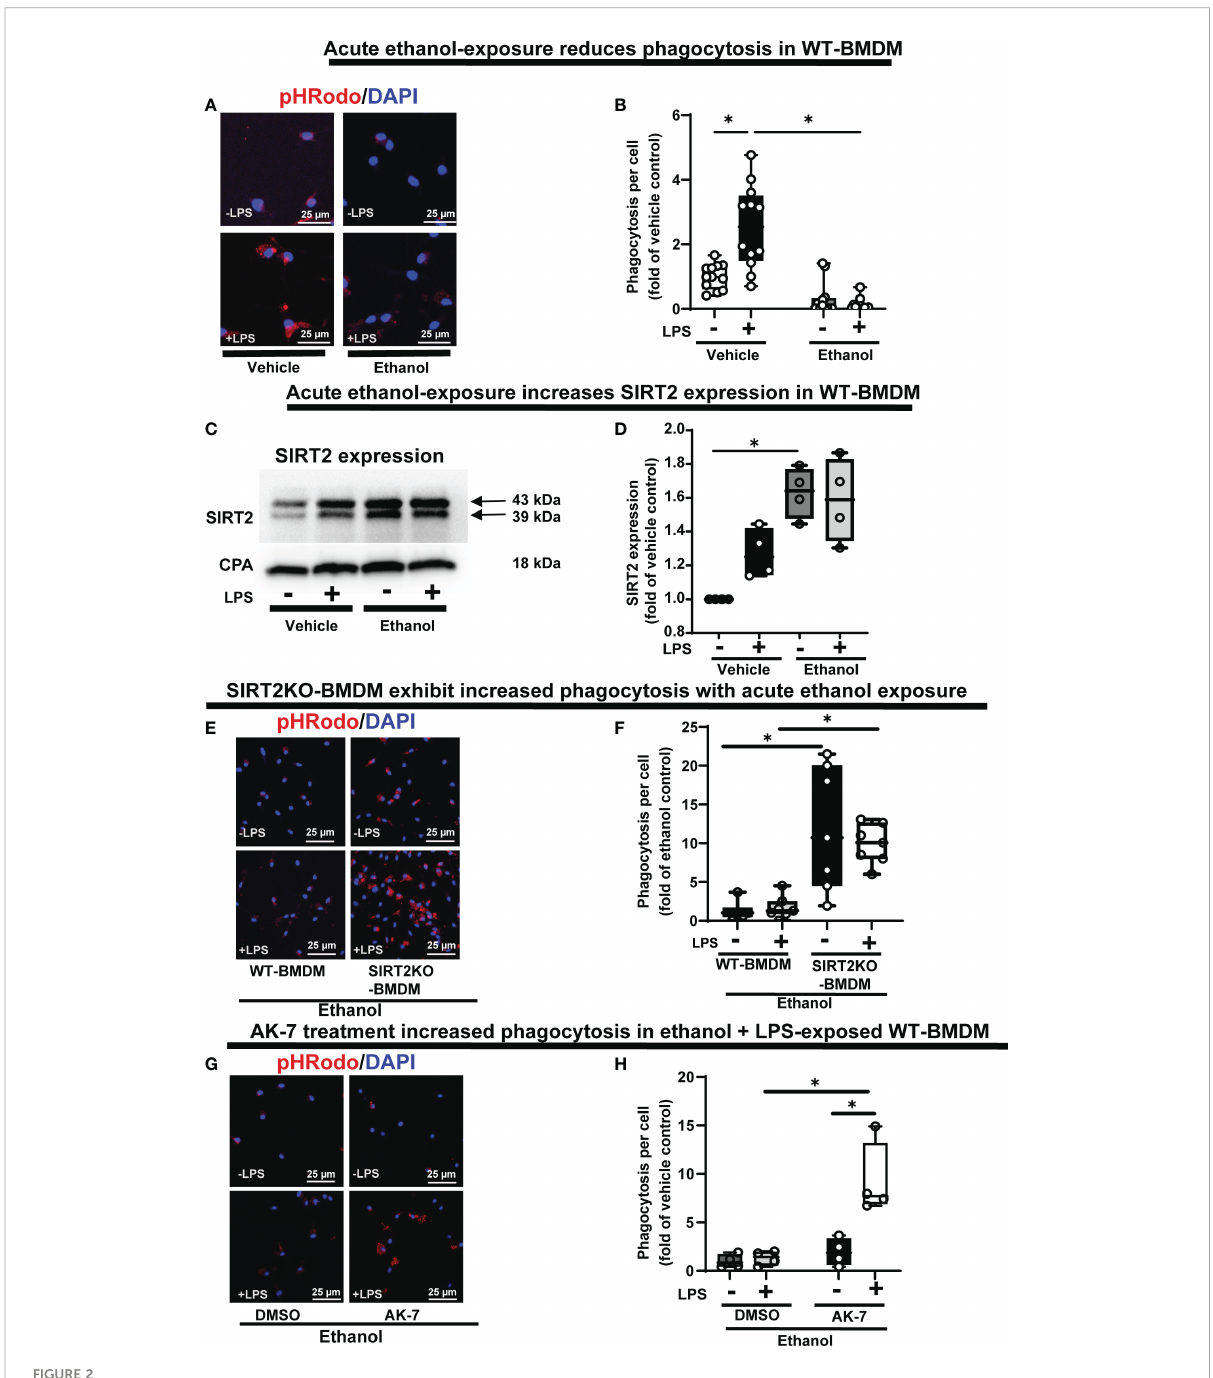
FIGURE 2 The effect of acute ethanol-exposure on mouse bone marrow derived macrophages (BMDM). Phagocytosis in BMDM exposed to vehicle or ethanol ± LPS to study phagocytosis using pHrodo bioparticles and SIRT2 expression. (A) Representative images of intracellular pHrodo bioparticles in vehicle or Ethanol-exposed WT-BMDM ± LPS. (B) Fluorescence quanti fi cation of pHrodo bioparticles in WT-BMDM (n=4 repetitions/group; * p<0.05). (C) SIRT2 protein expression detected by western blot in Vehicle- or Ethanol-exposed BMDM cells ± LPS. (D) Western blot image quanti fi cation of SIRT2 protein blot in vehicle or ethanol-exposed BMDM cells ± LPS (n = 4 blots/group; * p < 0.05). (E) Representative images of pHrodo bioparticles in Ethanol-exposed WT-BMDM and SIRT2KO-BMDM ± LPS. (F) Fluorescence quanti fi cation of pHrodo bioparticles in Ethanol-exposed WT-BMDM, and SIRT2KO-BMDM ± LPS. * p < 0.05. (G) Representative images of pHrodo bioparticles in Ethanol-exposed WT-BMDM, co-treated with SIRT2 inhibitor AK-7 or DMSO ± LPS. (H) Fluorescence quanti fi cation of pHrodo bioparticles in Ethanol-exposed WT-BMDM with AK-7/DMSO ± LPS stimulation. * p <